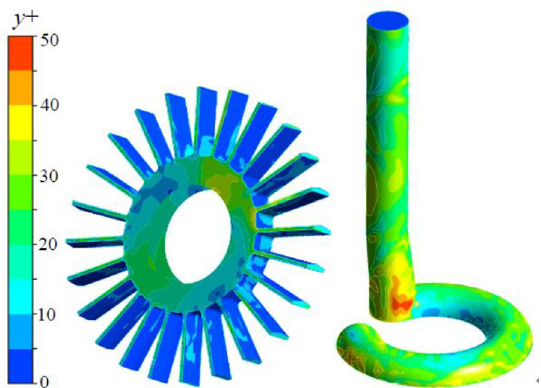
Figure 3 Distribution of y + on the surface of blades and side